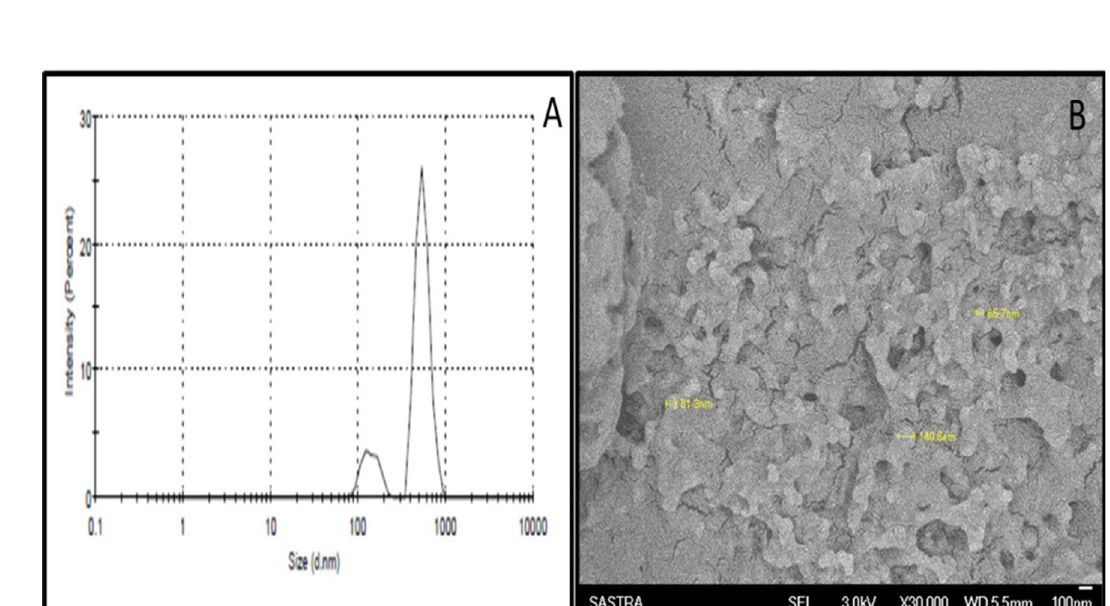
Figure 2. ( A ) Quasi elastic light scattering spectroscopy for the determination of particle size distribution. ( B ) Scanning electron microscopy for structure and morphology analysis (Magnification: ×